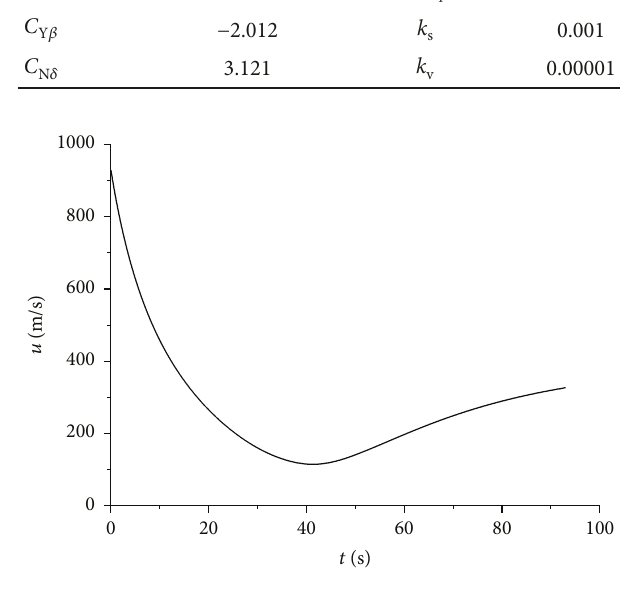
Figure 3: Velocity component u .